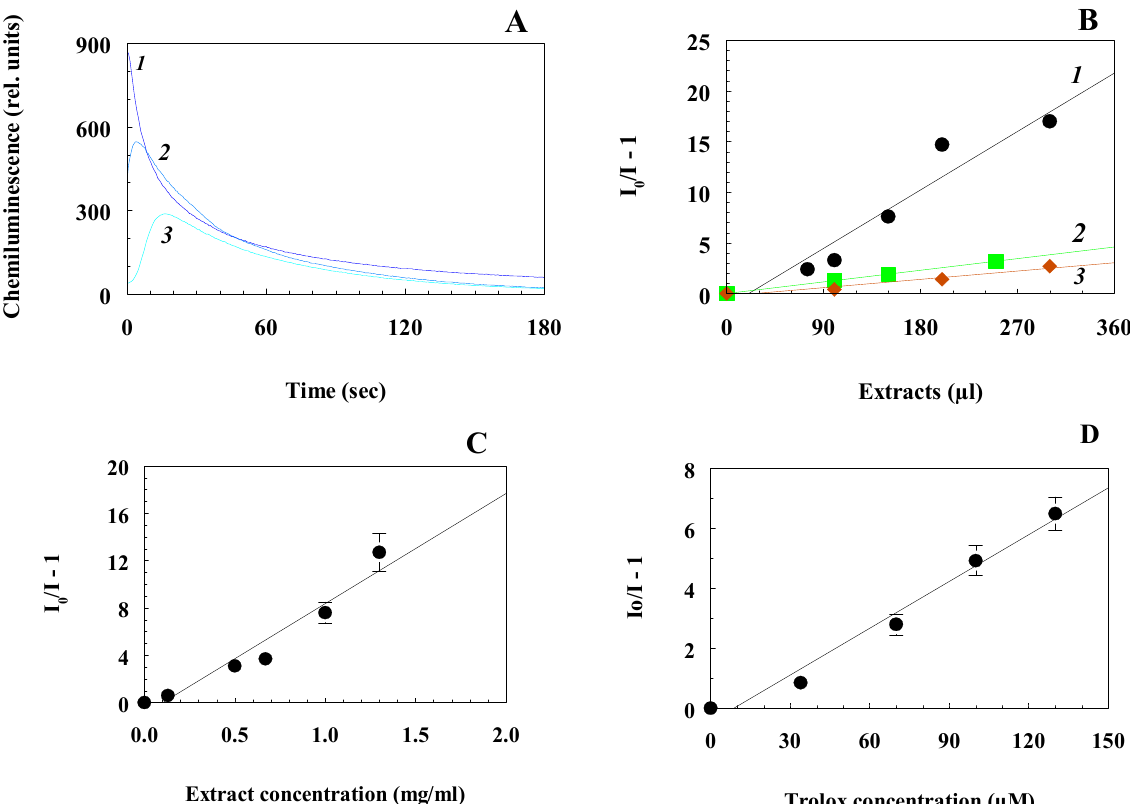
Figure 2. Determination of the antioxidant activity of the aqueous extract of the beetle by the chemiluminescent method: ( A ) quenching of luminol chemiluminescence by the original extract of the beetle (curve 3), the supernatant from it with the removed proteins (curve 1), and the remaining proteins (curve 2). All additives are 100 µ L of samples; ( B ) comparison of AOA for the original extract from the beetle (curve 1), protein-free supernatant (curve 3), and the filter residue (curve 2); ( C ) determination of the value of AOA of the whole (original) extract of the beetle; ( D ) determination of the value AOA of